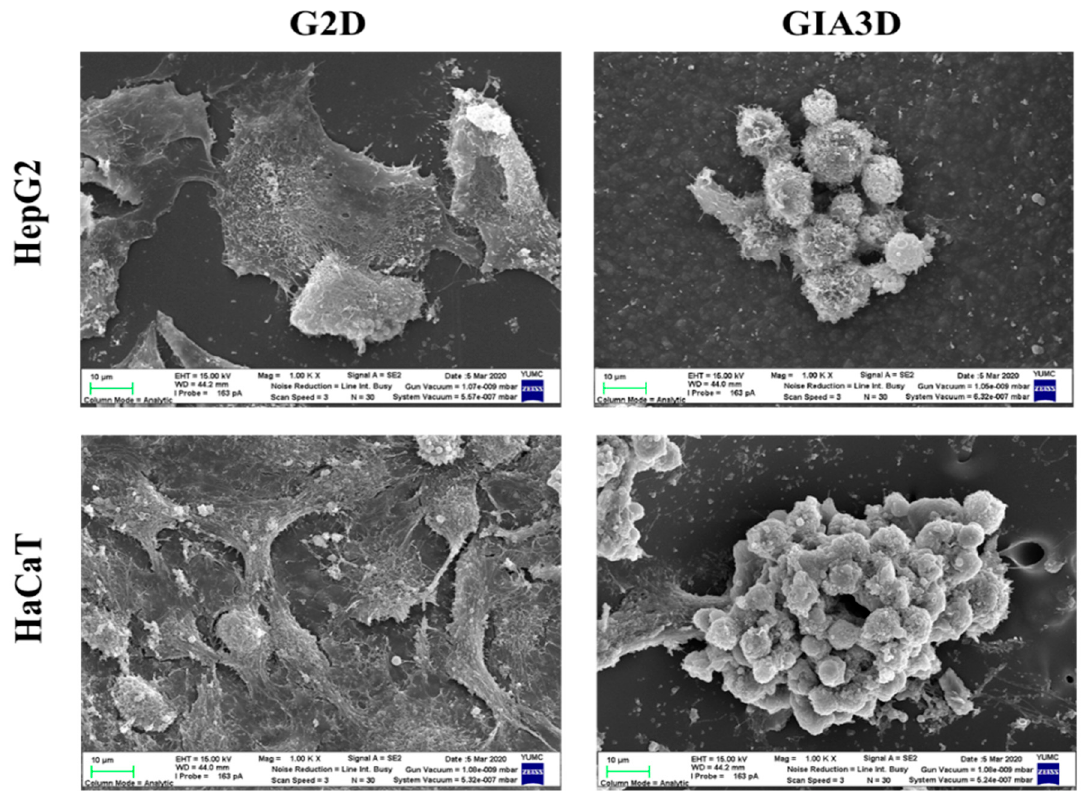
Figure 6. Morphology of human hepatoma cells (HepG2) and HaCaT cells in gold nanoparticles-coated 2D plate (G2D) and Au-NPs-coated industrial ABS scaffold (GIA3D) using SEM. Scale bar: 10 µm.